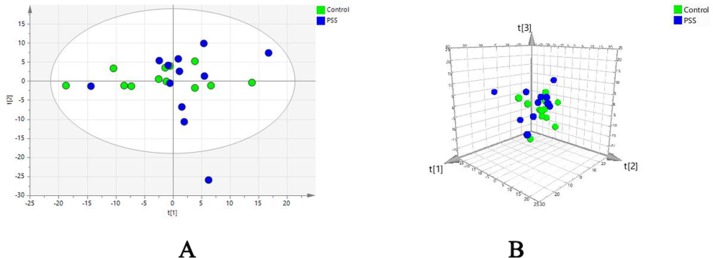
Principal component analysis. Principal component analysis scatter plots showing the first two (A) and three (B) principal components with control and PSS patients. PSS, Posner–Schlossman syndrome.